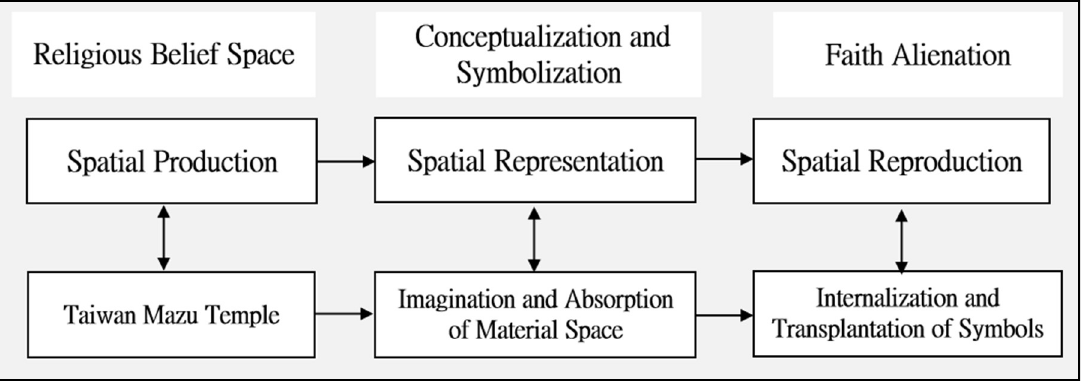
Figure 1. Research frark from the production of space perspective. Source: Compiled by author.